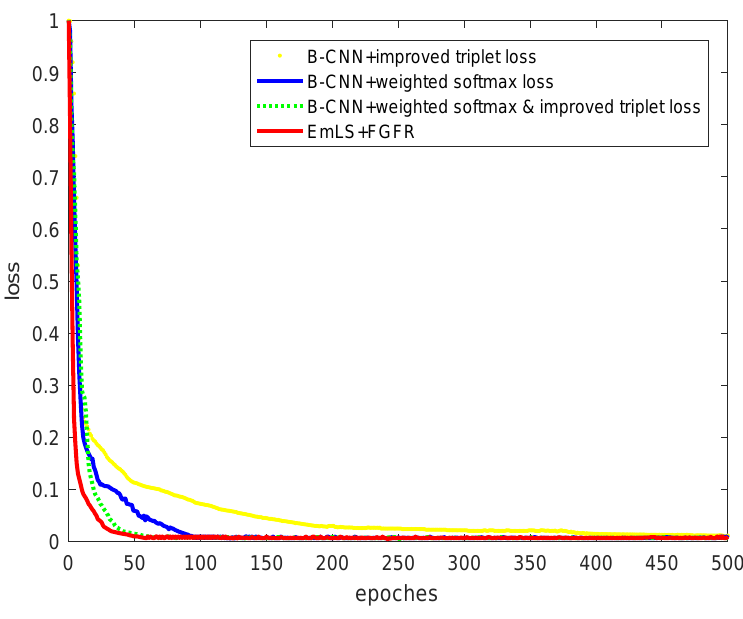
Figure 6. Convergence-rate